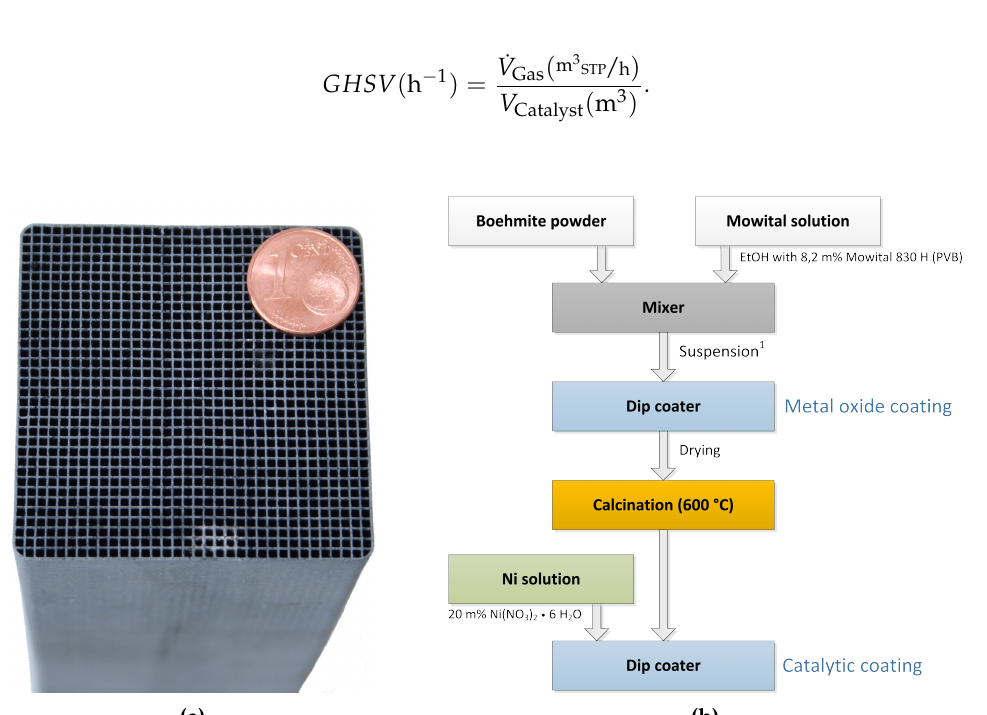
Figure 6. Example of honeycomb catalyst in lab scale and its coating process; ( a ) Honeycomb catalyst. A × B × H = 50 × 50 × 142 mm, cell density = 300 cpsi; ( b ) Coating process of ceramic honeycombs [30]; 1 Suspension: 60.0 g Mowital solution, 34.8 g Boehmite.